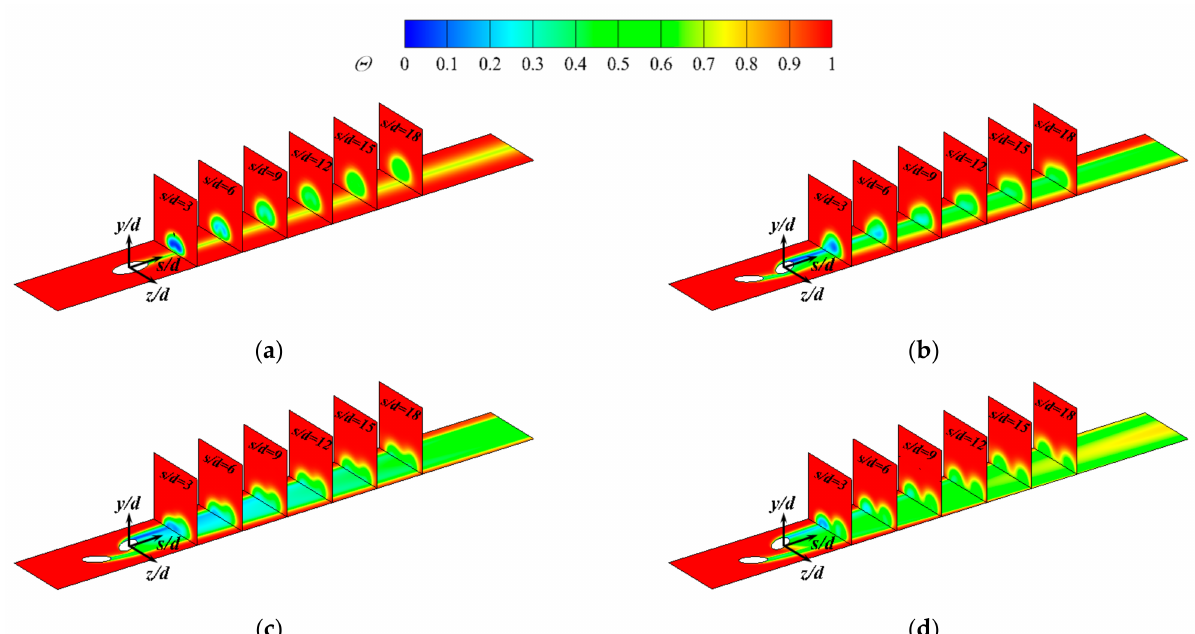
Figure 13. Dimensionless temperature contours in downstream normal sections on the pressure side under M = 1.5. ( a ) cylindrical hole, ( b ) Z / d = 0, β = 29 ◦ , ( c ) Z / d = 0.5, β = 29 ◦ , ( d ) Z / d = 1.0, β = 29 ◦